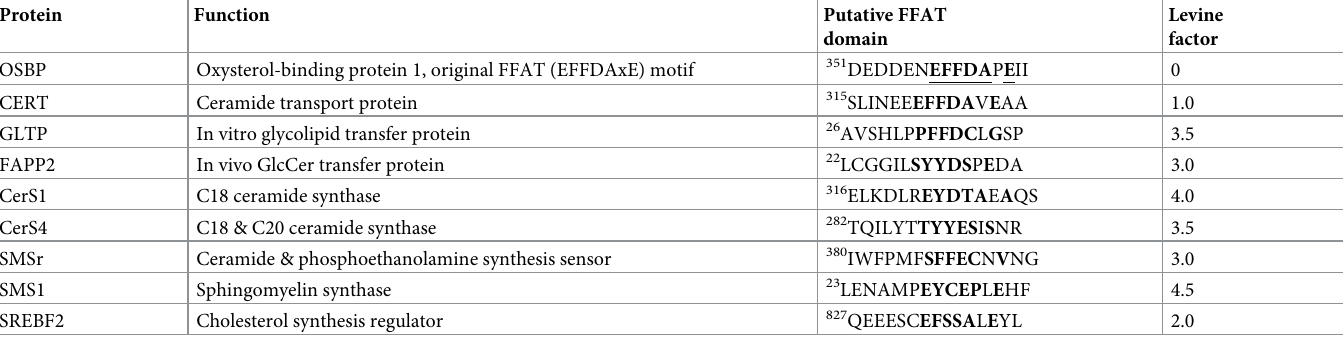
Table 1. List of putative FFAT-like domains found in proteins related to the sphingolipid synthesis.